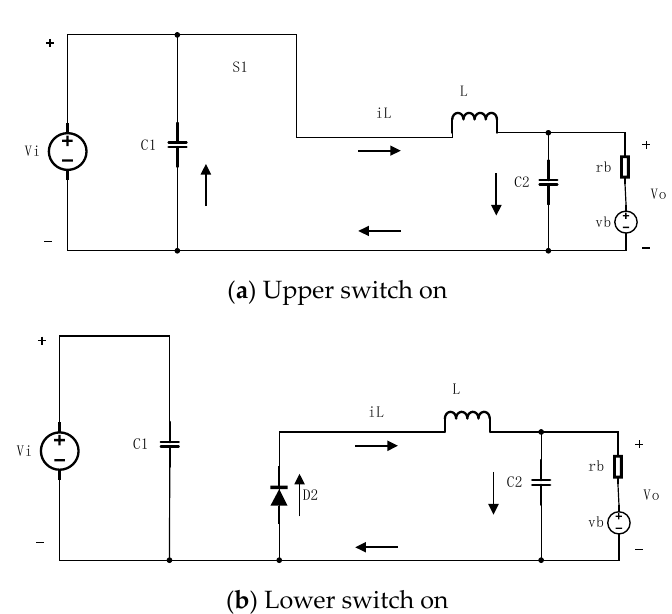
Figure 4. Equivalent circuit in buck